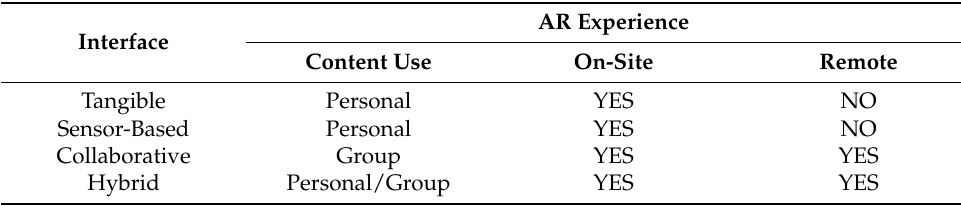
Table 1. Interface comparison concerning AR